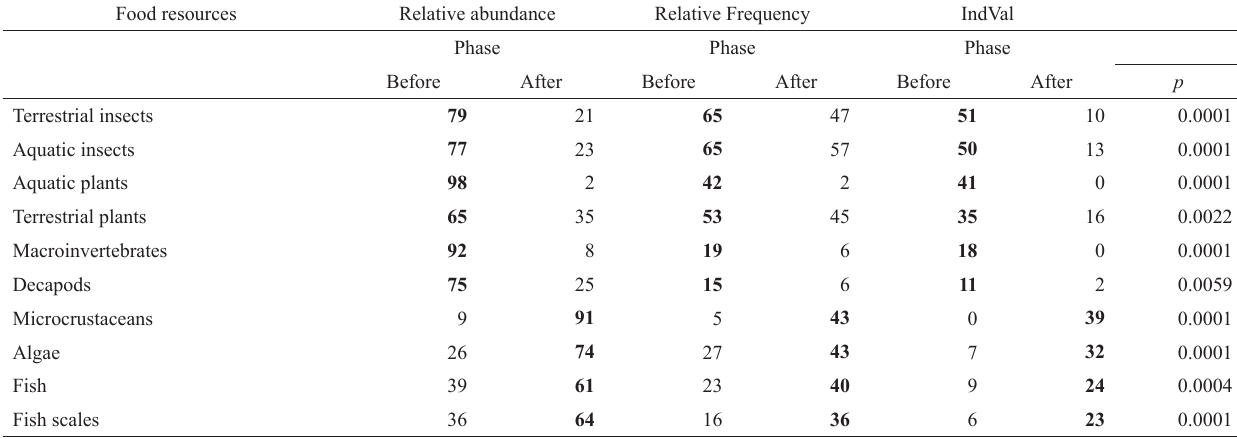
Table 6. Summary of the indicator species analysis showing the Relative Abundances (RA), Relative Frequencies (RF) and indicator values (IndVal) of food resources used by the fish fauna, before and after the impoundment of the Salto Caxias Res- ervoir, Iguaçu River (only food resources with significant values are listed). Bold font indicates significant indicator values (p<0.05, Monte Carlo permutation test).